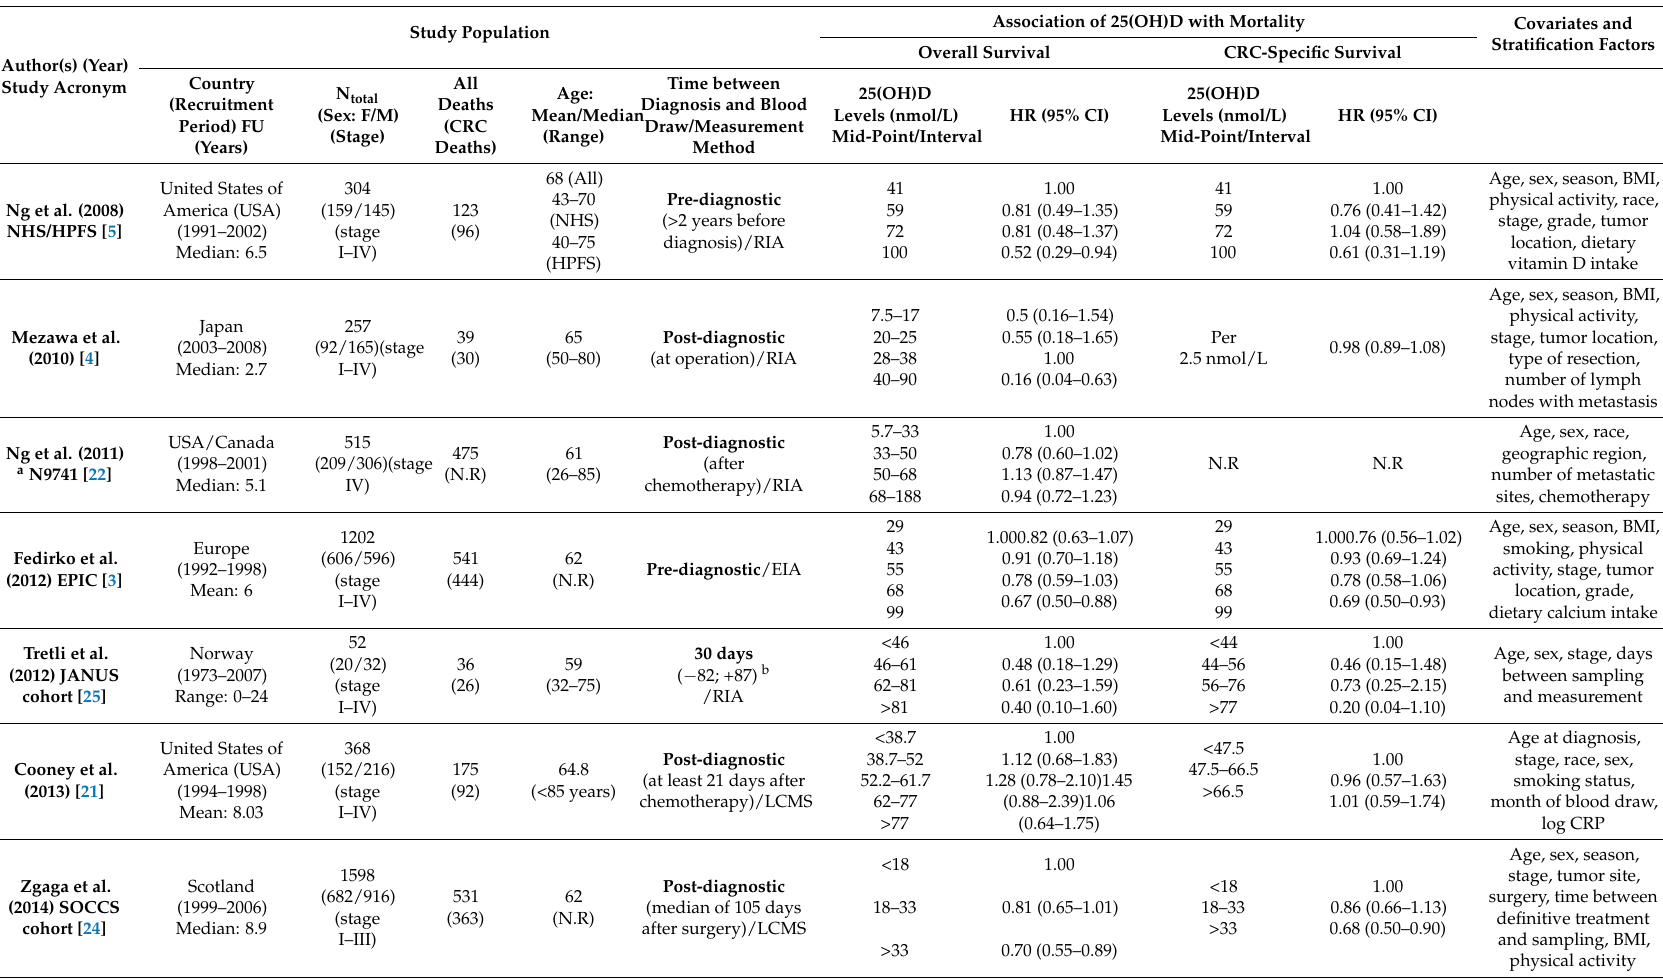
Table 1. Studies reporting on the association of serum 25(OH)D levels (nmol/L) with overall and CRC-specific mortality among CRC